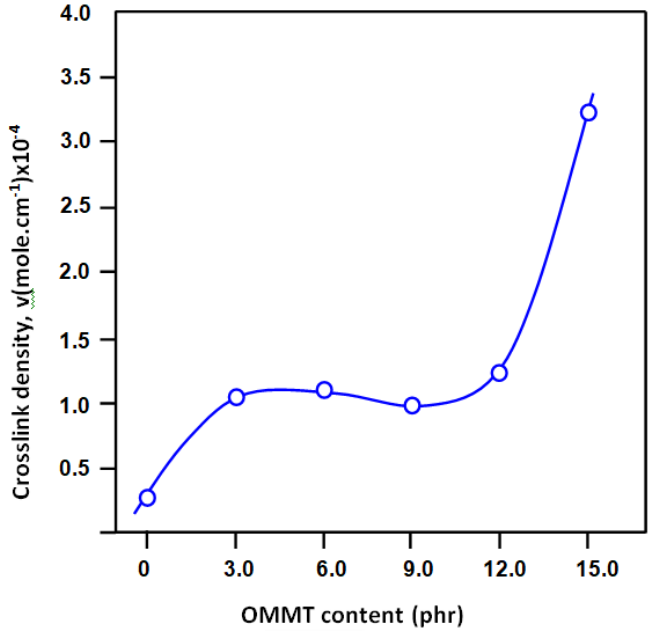
Figure 7. Variation of crosslink density of CSBR versus the OMMT content in the CSBR/OMMT membrane.